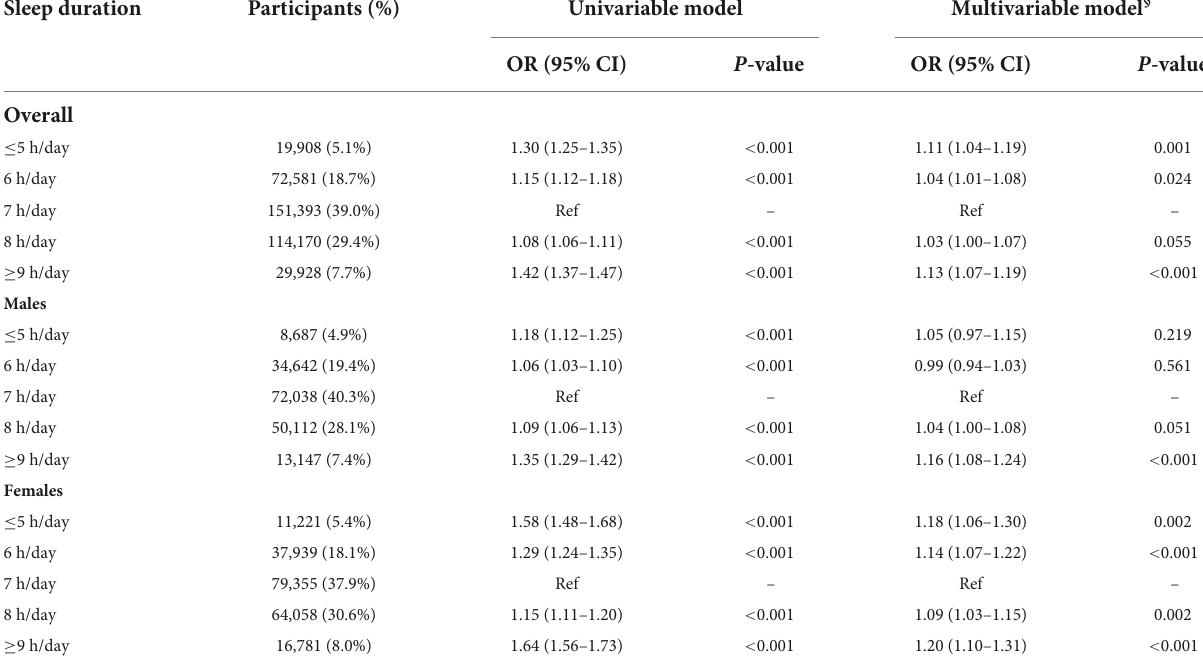
TABLE 2 The observational association between sleep duration and